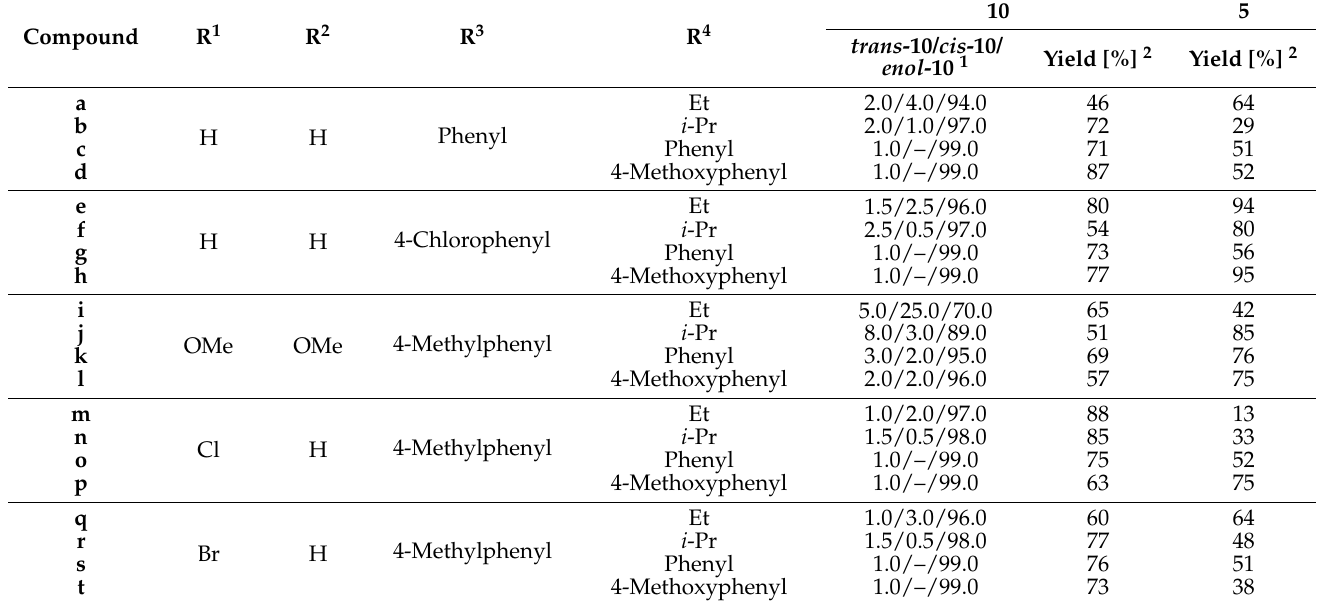
Table 1. Yields of trans - and cis -3-(diethoxyphosphoryl)-1-sulfonyl-2,3-dihydroquinolin-4-ones trans - and cis - 10a-t , 3-(diethoxyphosphoryl)-1-sulfonyl-2,3-dihydroquinolin-4(1 H )-ols enol - 10a-t , and 3- methylidene-1-sulfonyl-2,3-dihydroquinolin-4(1 H )-ones 5a-t